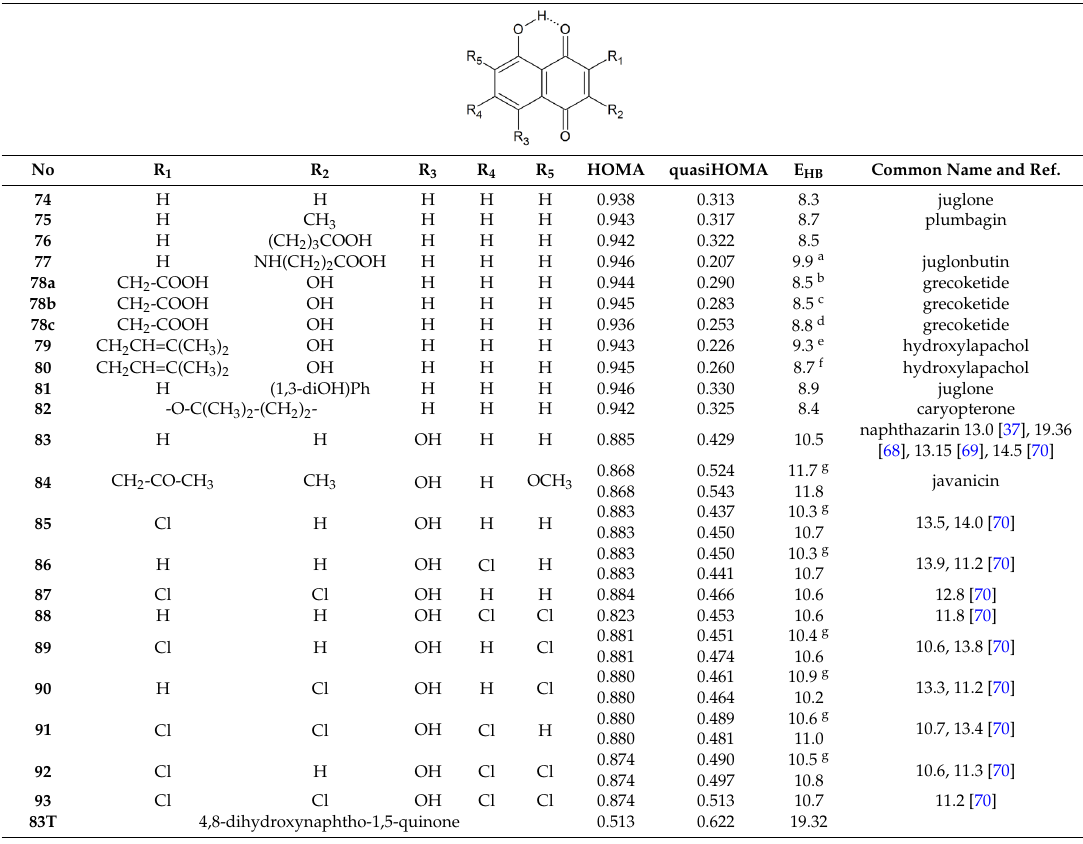
Table 2. HOMA and quasiHOMA indices and energy of hydrogen bond (kcal/mol) calculated for hydrogen bonding (HB) ring in substituted hydroxynaphthoquinones structures; common names of some natural products and the cited energetic data were given in the last column.